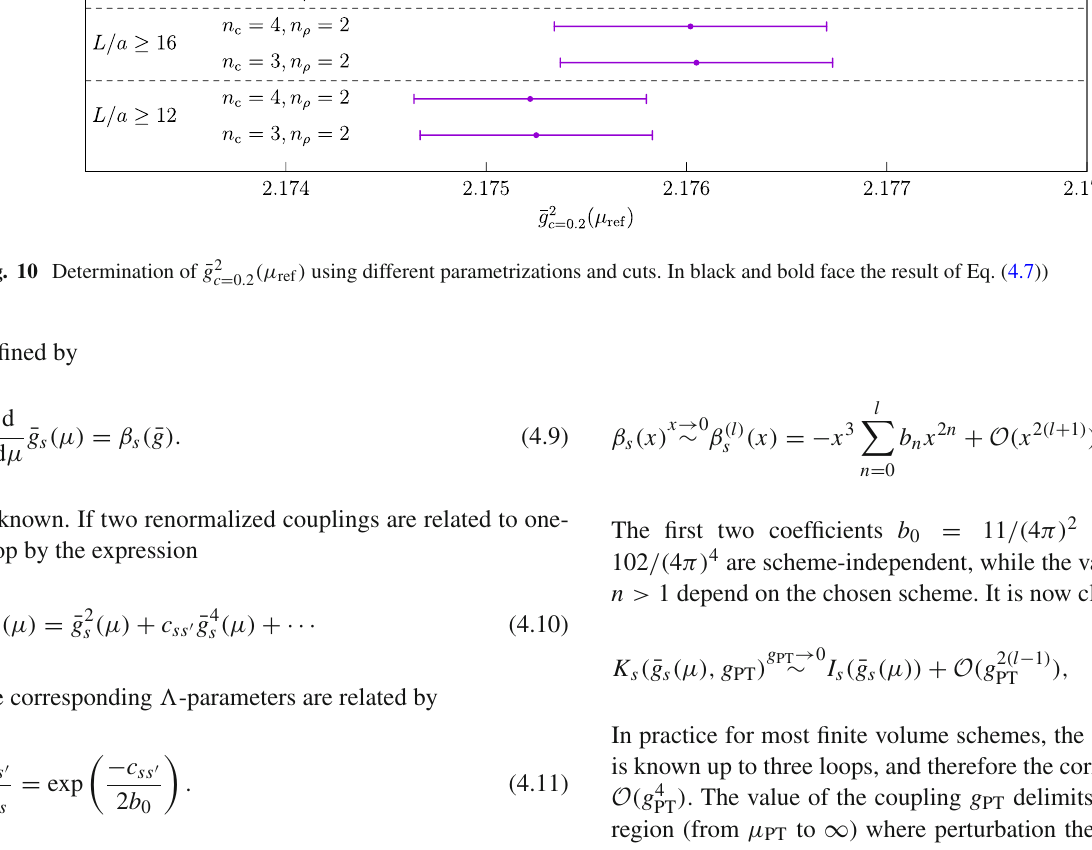
(μ ) using different parametrizations and cuts. In black and bold face the result of Eq. (4.7)) ref c = 0 . 2